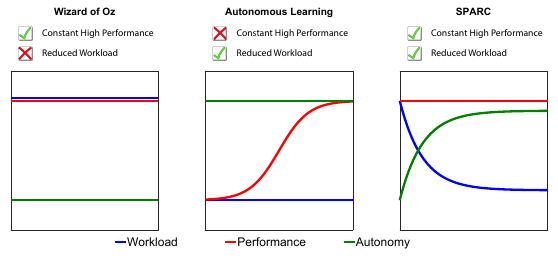
Figure 12: Comparison of expected ideal behaviours for